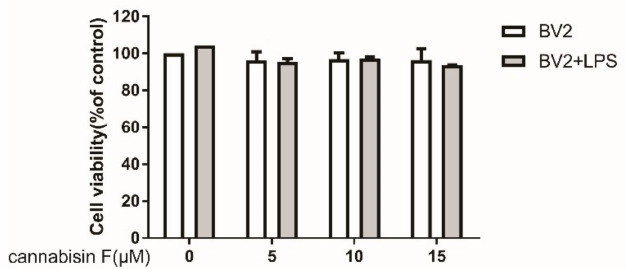
Figure 2. Cannabisin F at concentrations from 5 to 15 µ M did not affect the viability of BV2 microglia cells with or without stimulation with LPS at 100 ng/mL for 24 h. Results are expressed as mean ± SD (Standard Deviation) from three independent